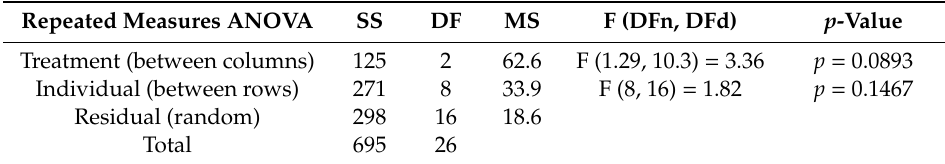
Table 3. ANOVA statistics of AM mRMS values at the beginning of the session (day 1, week 6 and week 12). Repeated Measures ANOVA SS DF MS F (DFn, DFd) p -Value Treatment (between columns) 125 Individual (between rows) 271